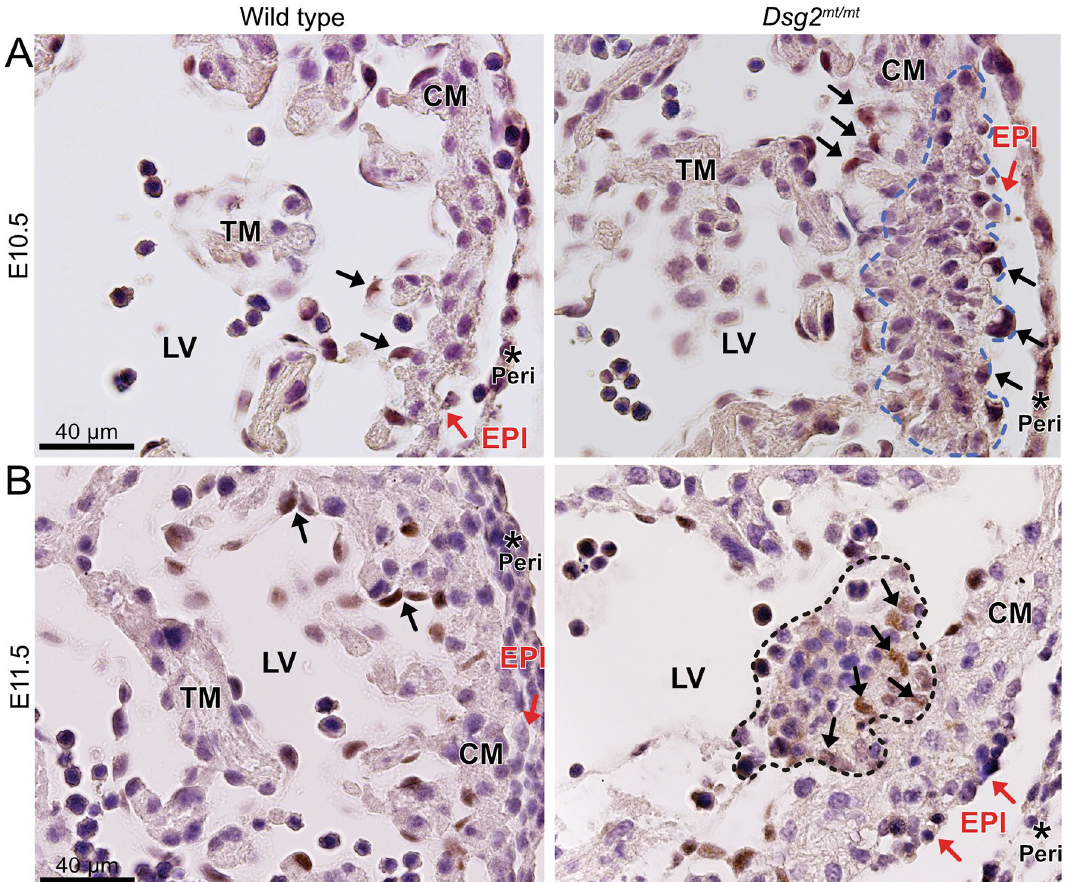
Figure 7. The expression pattern of cleaved Notch1 (N1ICD) is altered in Dsg2 mt/mt embryonic hearts. The images show immunohistological sections of E10.5 ( A ) and E11.5 ( B ) wild-type and Dsg2 mt/mt hearts. ( A ) Black arrows point to N1ICD + endocardial cells in the wild-type heart. In contrast, altered-shaped endo and epicardial N1ICD + cells (black arrows) surround disorganized cardiomyocytes (blue dashed line) in Dsg2 mt/mt heart. Data are representative images of three wild type and two Dsg2 mt/mt hearts per group. ( B ) Note, that N1ICD + cells are restricted to scattered endothelial cells in the wild type (black arrows) but are also detectable in Dsg2 mt/mt myocardium (black arrows) harboring a type A cluster (dashed line) next to disarranged cardiomyocytes with mesenchymal-like morphology. LV, left ventricle; RV, right ventricle; TM, trabecular myocardium; CM, compact myocardium; red arrows, epicardium (EPI), *, pericardium (Peri). Data are representative images of wild-type and Dsg2 mt/mt hearts (n = 3 per group). Size bars: 40 μm in ( A ) (same magnification in left and right image) and ( B ) (same magnification in left and right